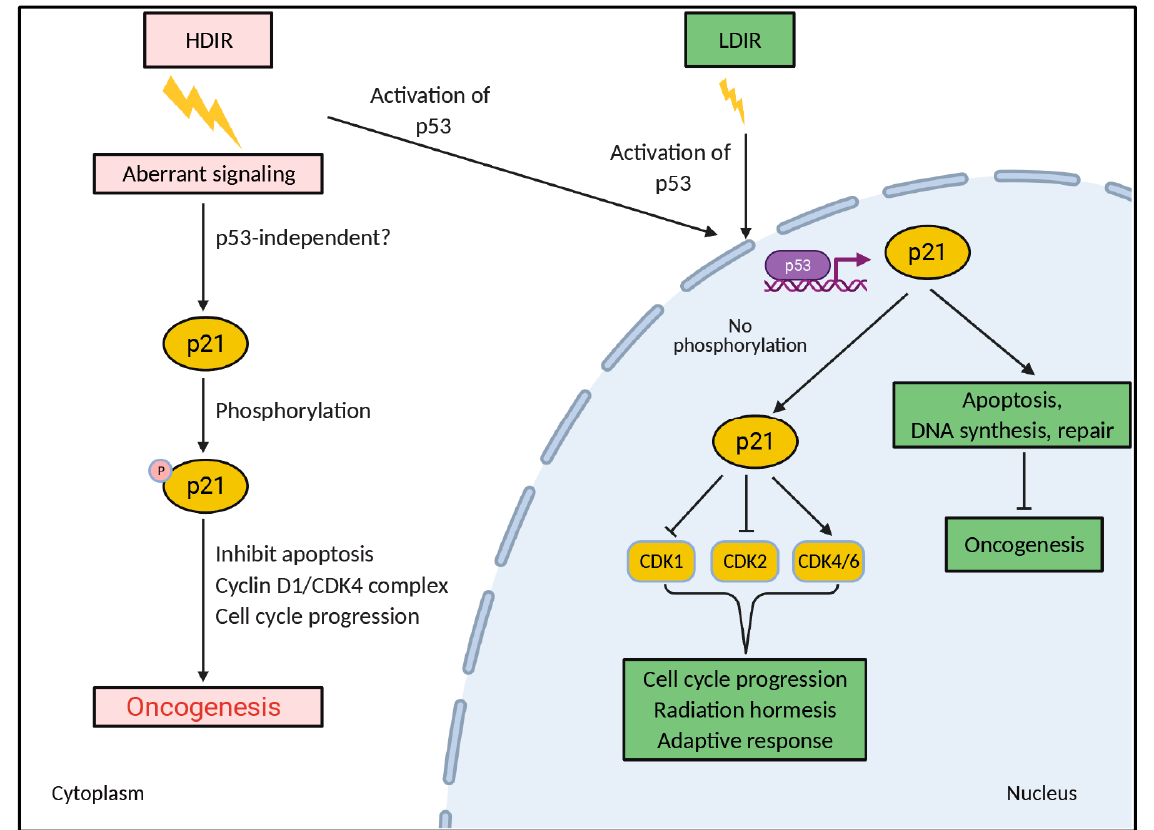
Figure 2. Conceptual diagram showing that radiation dose might differentially regulate the nucleocytoplasmic shuttling of p21 Waf1 . The nuclear function of p21 Waf1 is predominantly cell cycle inhibitory and tumor suppressive, whereas cytoplasmic p21 Waf1 can exert antiapoptotic functions. Aberrant cell signaling induced by HDIR might cause phosphorylation of p21 Waf1 leading to its cytoplasmic localization. Similar to LDIR, HDIR also induces p53-dependent transcription of p21 Waf1 and p21 Waf1 nuclear functions.